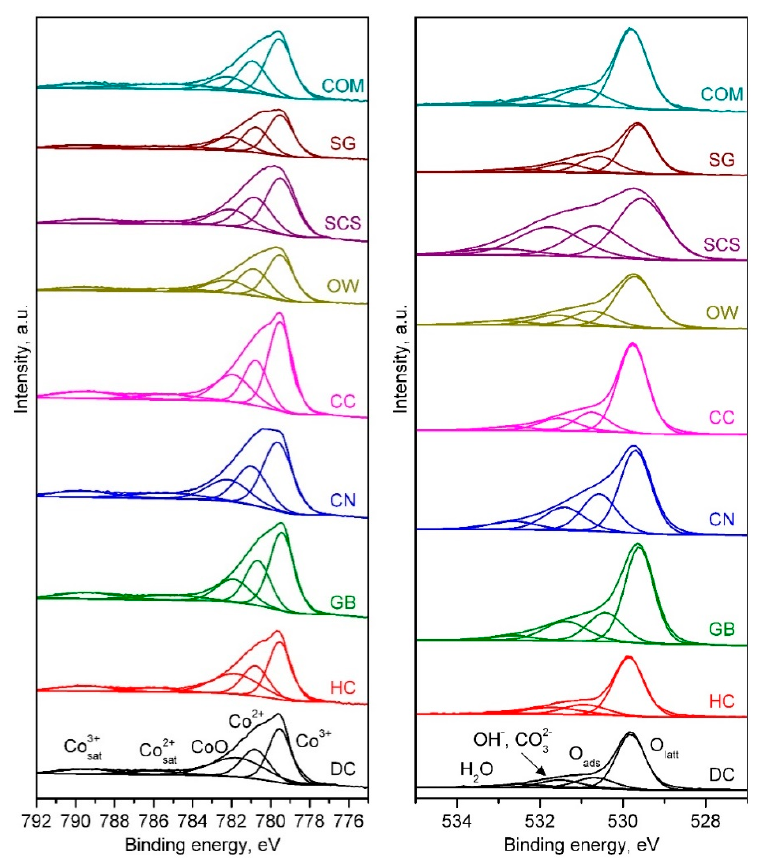
Figure 4. Co2p 2/3 ( left ) and O1s ( right ) XPS spectra of the bulk Co 3 O 4 catalysts.